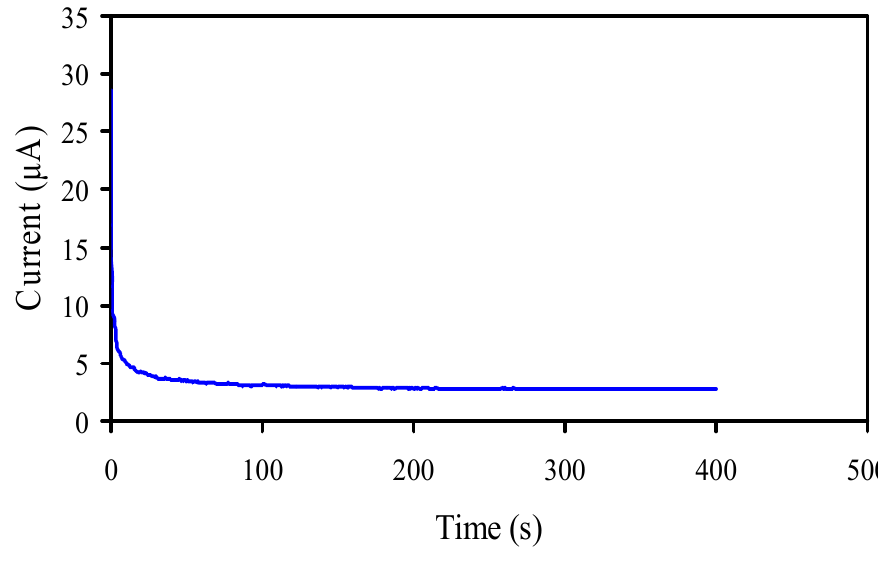
Figure 8. Polarization current vs. time for the highest plasticized sample (PSP_2) at RT.